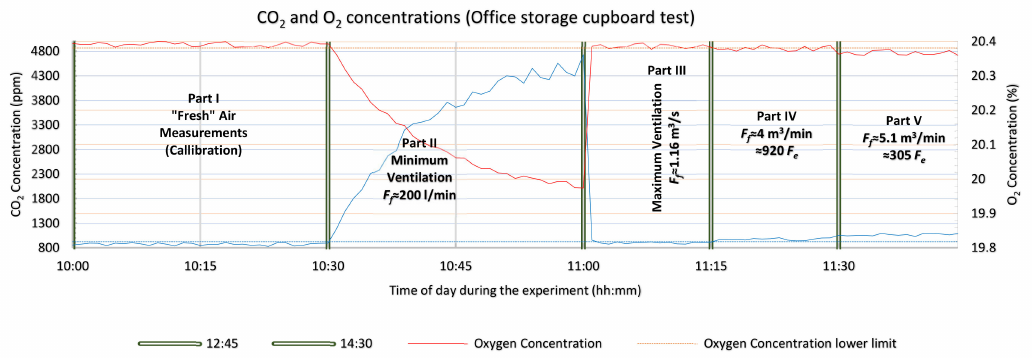
Figure 4. Extended office storage cupboard with one person test